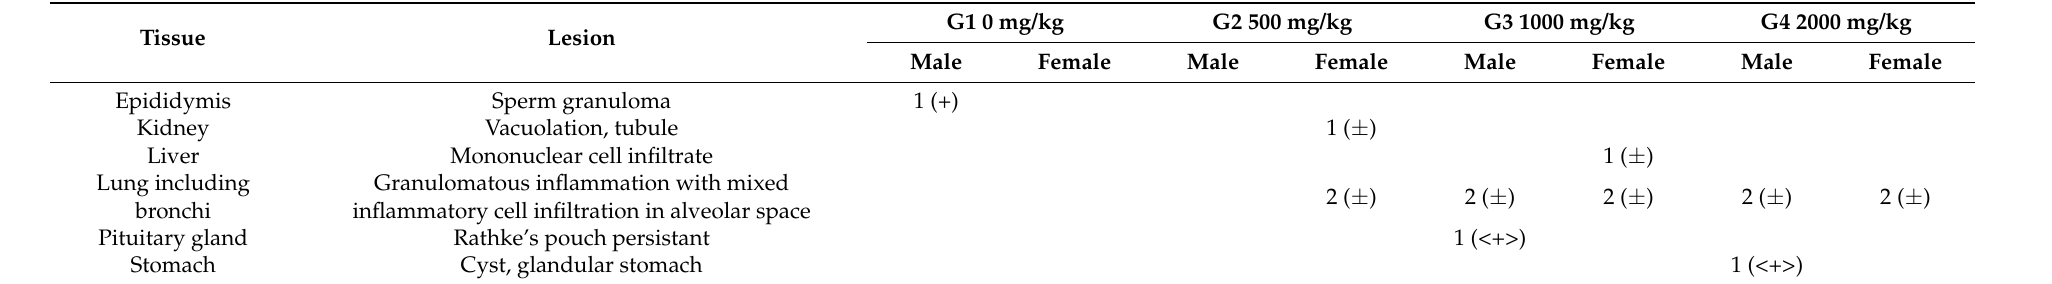
Table 2. Histopathology analysis of mice from 28-day repeated oral dose toxicity study. ± : minimal grade; <+>: presence of